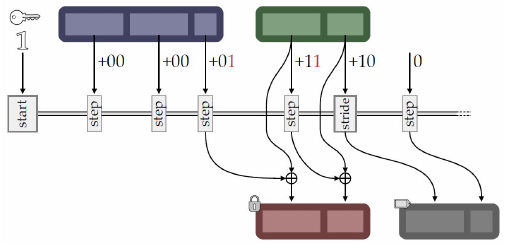
Figure 3: Wrapping a header and a body with MonkeyWrap [BDP +